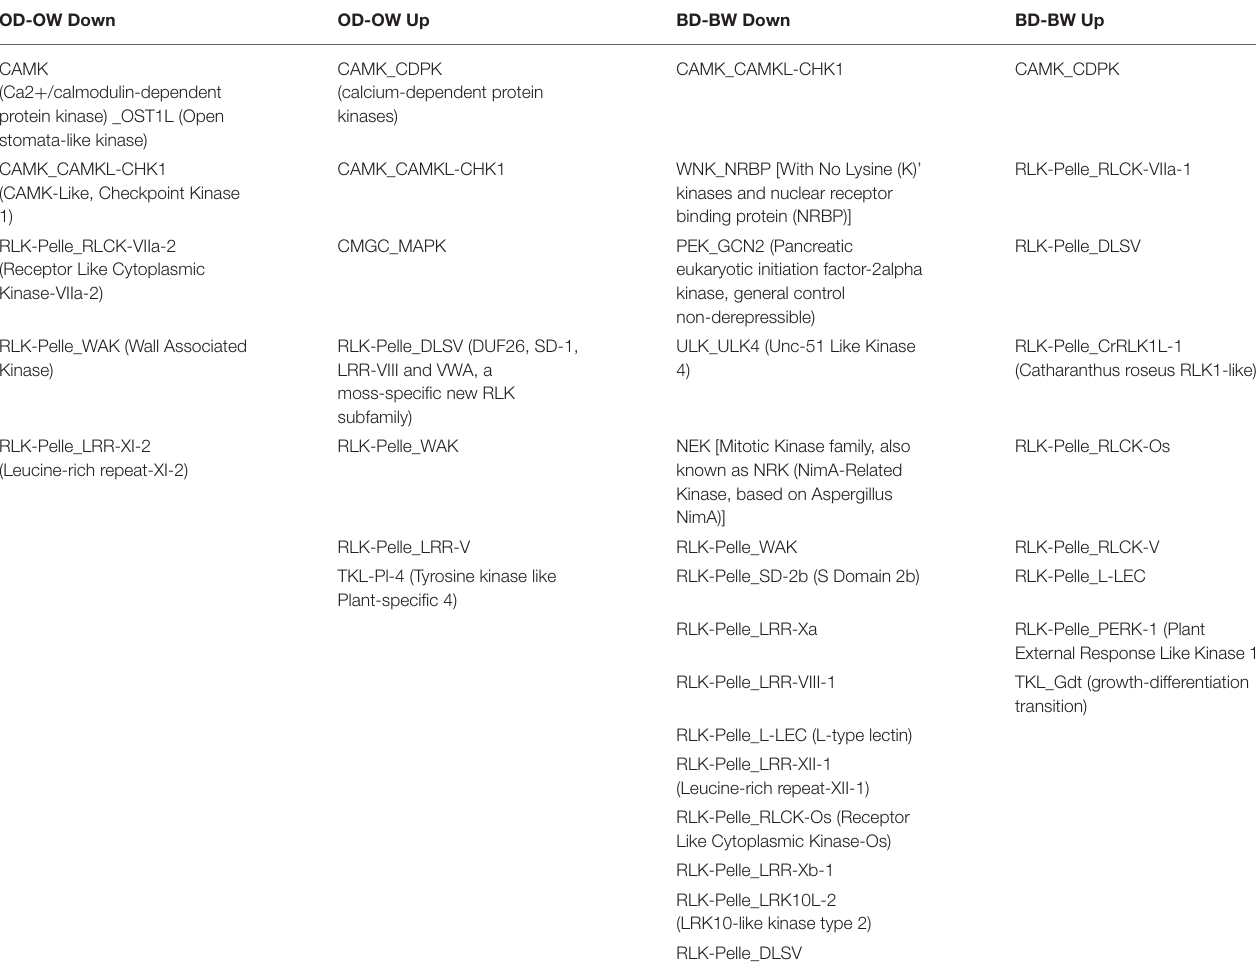
TABLE 5 | The differentially expressed kinases in Otis and Baronesse under drought stress. OD-OW Down OD-OW Up BD-BW Down BD-BW Up CAMK (Ca2 + /calmodulin-dependent protein kinase) _OST1L (Open stomata-like